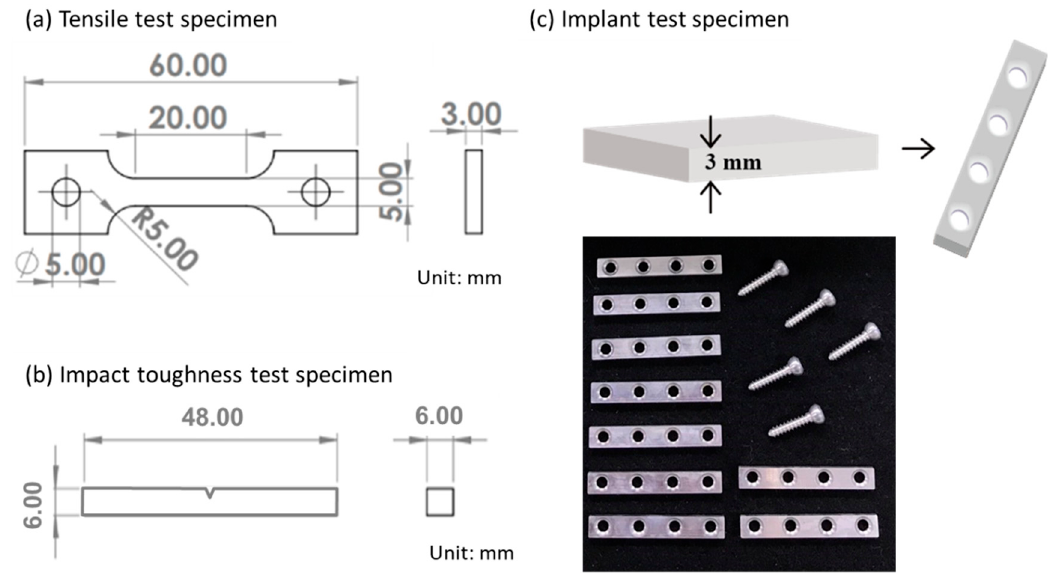
Figure 2. Geometry of test specimens: ( a ) tensile test, ( b ) impact toughness test, and ( c ) illustration and photograph of the ZKX500 bone plates.